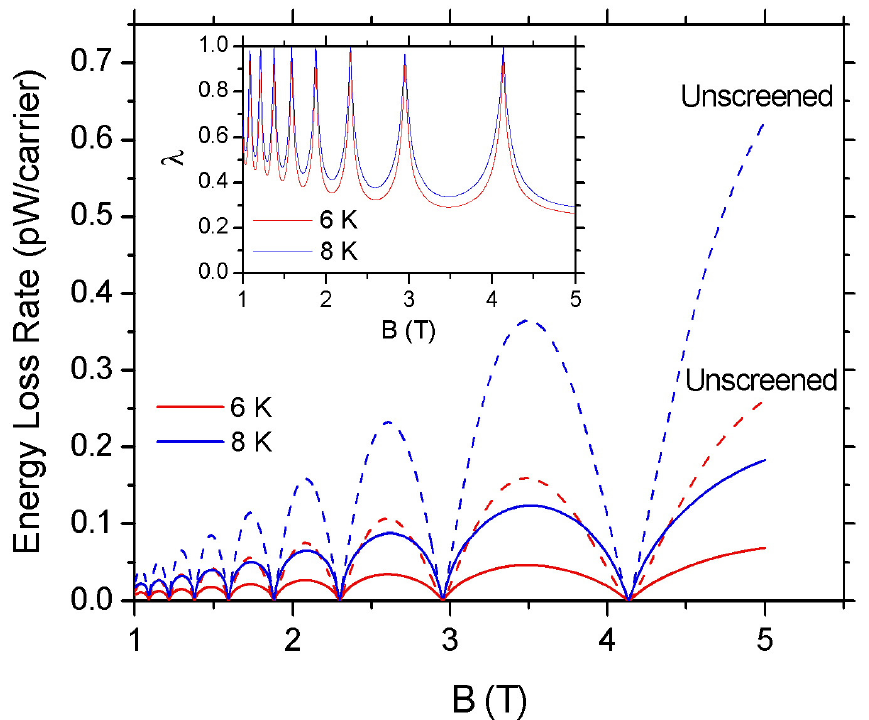
Figure 4. Screening effect on the energy loss rate of an MLG with n s = 10 16 m − 2 . The solid red and blue lines are the calculated ELR values as a function of B when screening is taken into account for T e = 6 K and 8 K, respectively. The dashed lines show the corresponding results when (cid:101) ( q ) = 1 (without screening). In the inset, the ratio λ of the screened over the unscreened results is shown as a function of B for T e = 6 K and 8 K. ( γ = 2 meV/T 1/2